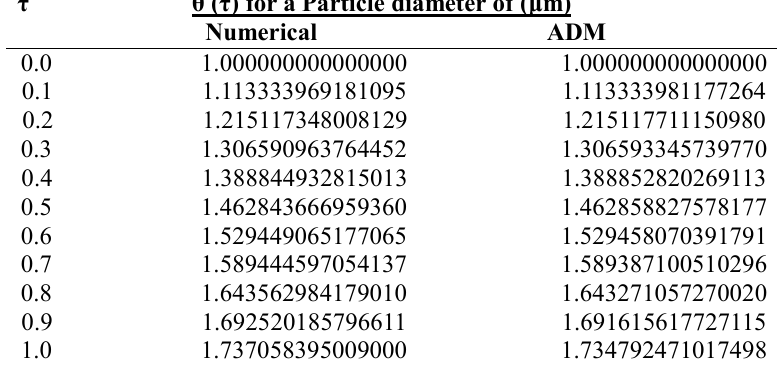
Comparison of ADM results with a numerical method for a 20μm iron particle